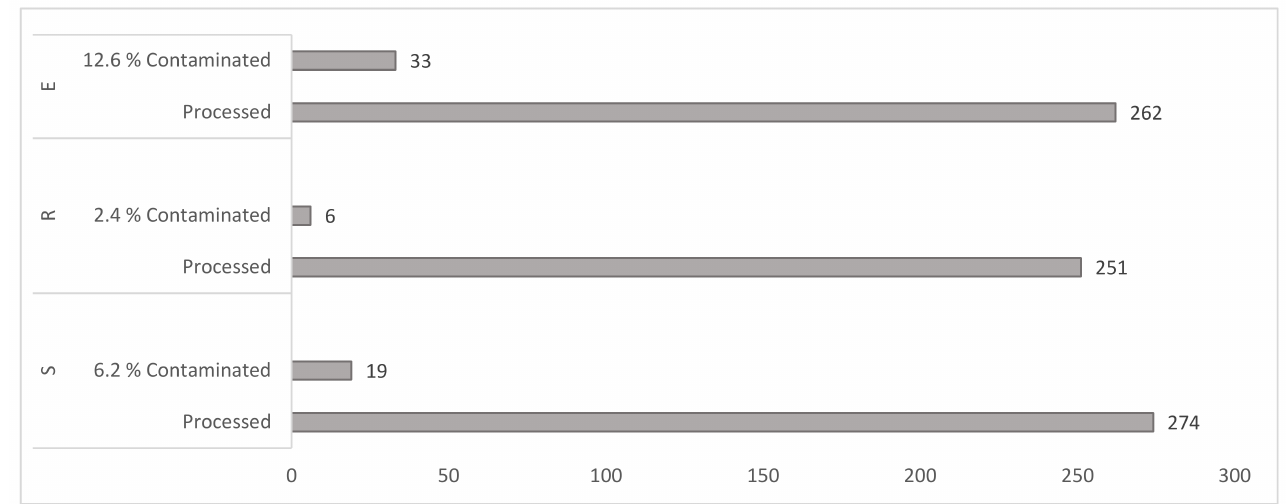
Figure 1. Samples contamination rates. Figure interpretation. S = water sediments (including sewage sludge from wastewater treatment plants), R = raw plant material and peat, E = animals’ faeces and matrices of animal